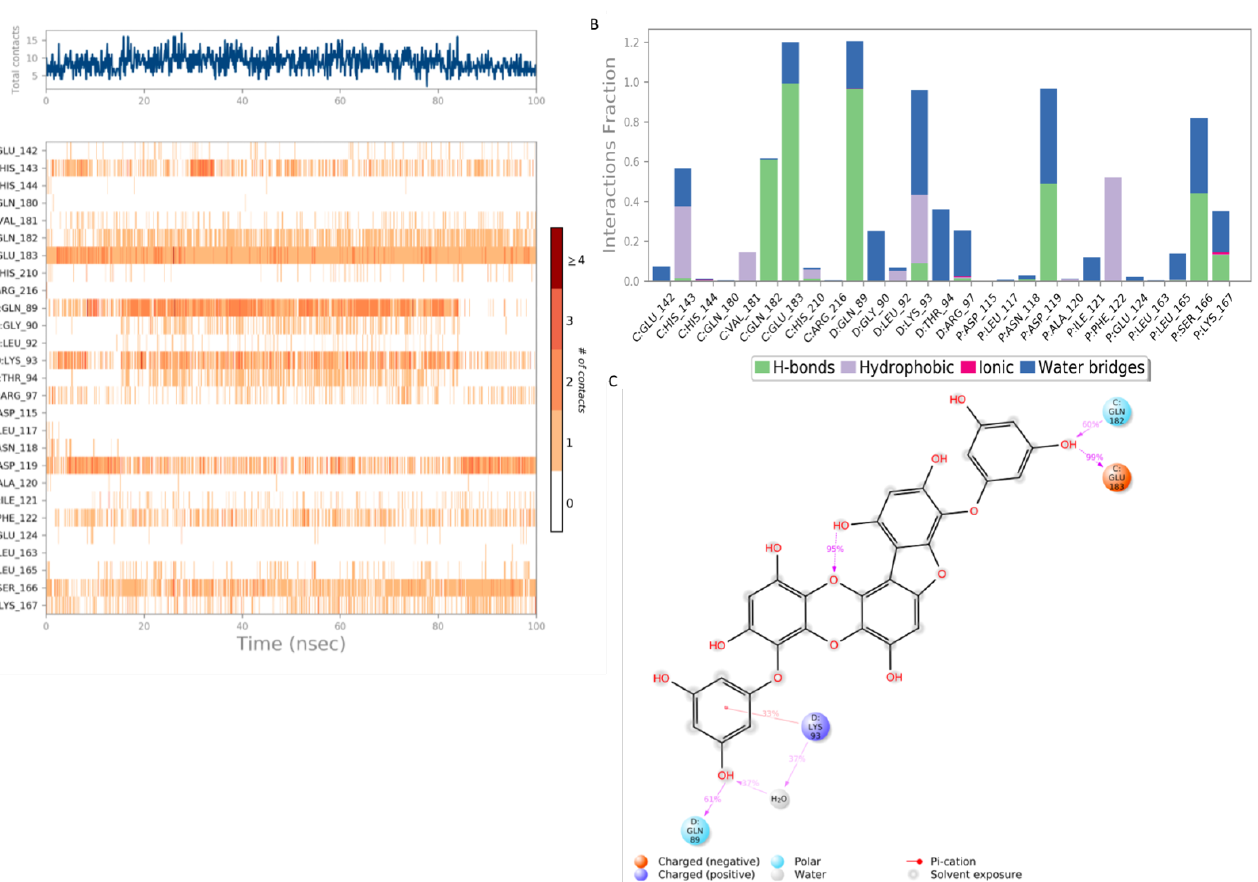
Figure 6. Interaction diagram of phlorofucofuroeckol with the GTPCH1-binding pocket. ( A ) Interaction of phlorofucofuroeckol with residues in each trajectory frame. The depth of color indicates the level of interaction with contact residues; ( B ) the protein – ligand contacts show the bonding interaction fractions and the nature of the interactions; ( C ) graphical 2D illustration of phlorofucofuroeckol interacting with the protein residues during MD simulation. Interactions shown occurred over 30% of the simulation time. C — chain C of the GTPCH1-binding pocket; D — chain D of the binding pocket; P — chain P of the binding pocket.